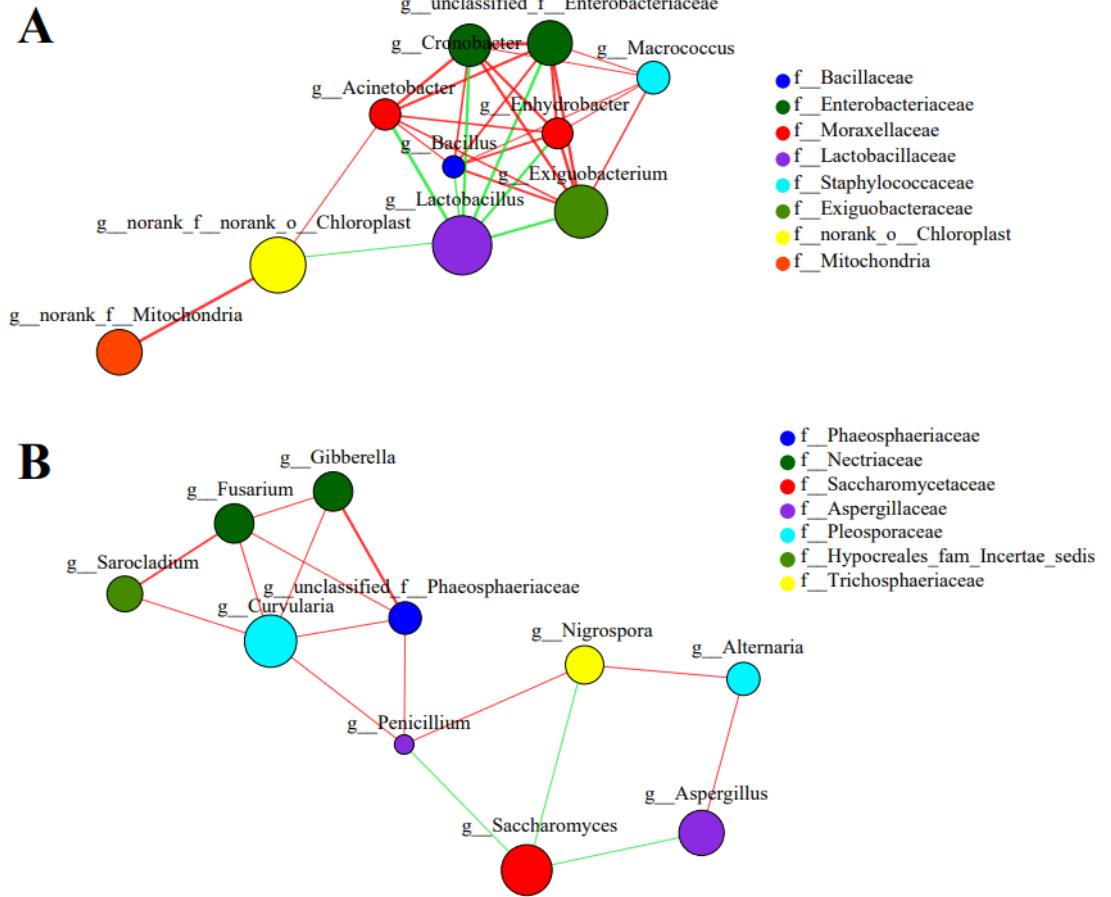
Figure 4. Correlation network of bacterial ( A ) and fungal ( B ) occurrence patterns during fermentation. Only correlations with top 10 were shown. Nodes represent genera and lines represent co-occurrence (R > 0.6, p < 0.05, red lines) or co-exclusion (R < − 0.6, p < 0.05, green lines).